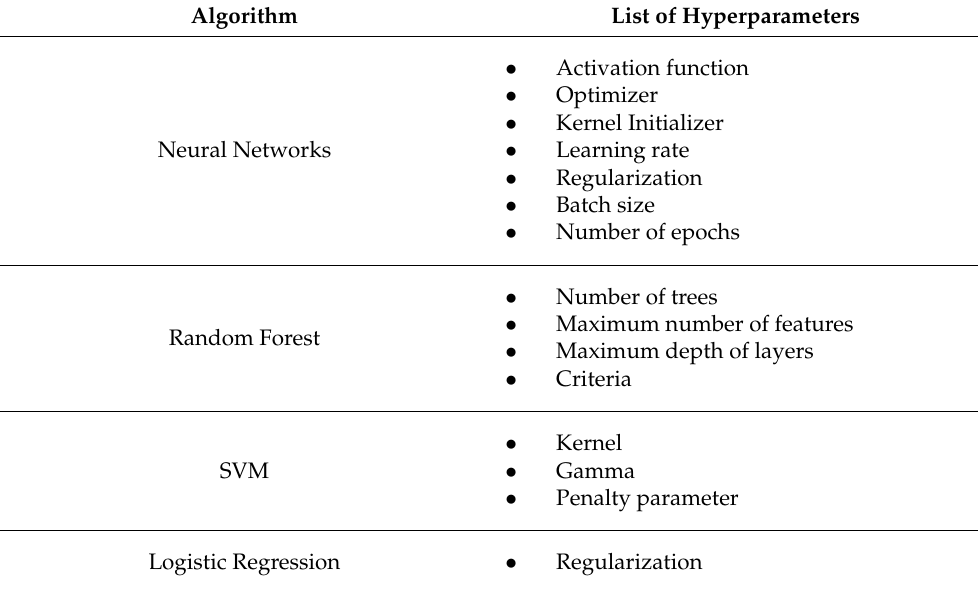
Table 1. The hyperparameters for each algorithm.